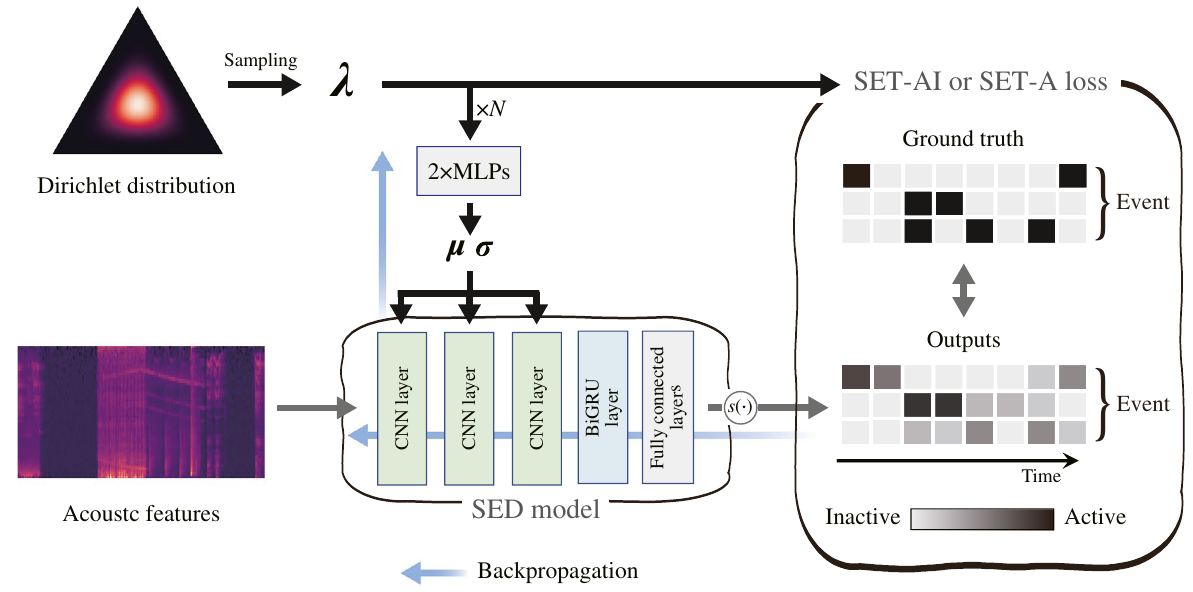
Fig. 2 Overview of SET in training